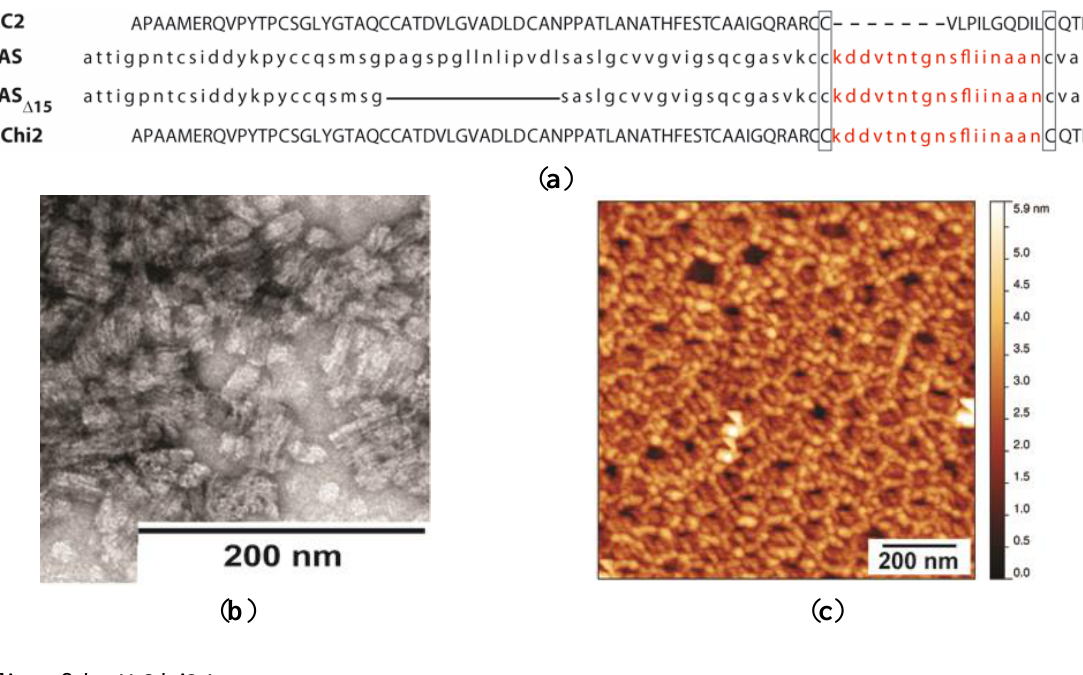
Figure 6. ( a ) Sequence alignment illustrating the construction of the chimeric hydrophobin NChi2 from the proteins NC2 and EAS (named for its easily wettable spore phenotype). The Cys7–Cys8 region of NC2 is shorter than the corresponding region in EAS and EAS this difference is indicated with a dotted line. The 15-residue deletion from EAS, to generate EAS , is indicated by a solid line. The conservation of the amyloidogenic region between ∆15 EAS, EAS and NChi2 is indicated in red; ( b ) TEM image of negatively stained NChi2 ∆15 rodlets formed under conditions of low pH (=2.5) and elevated temperature (45 °C) with extended shaking. ( c ) AFM image of NChi2 dried down from pH = 2.5 at 45 °C and then washed with MQW for 5